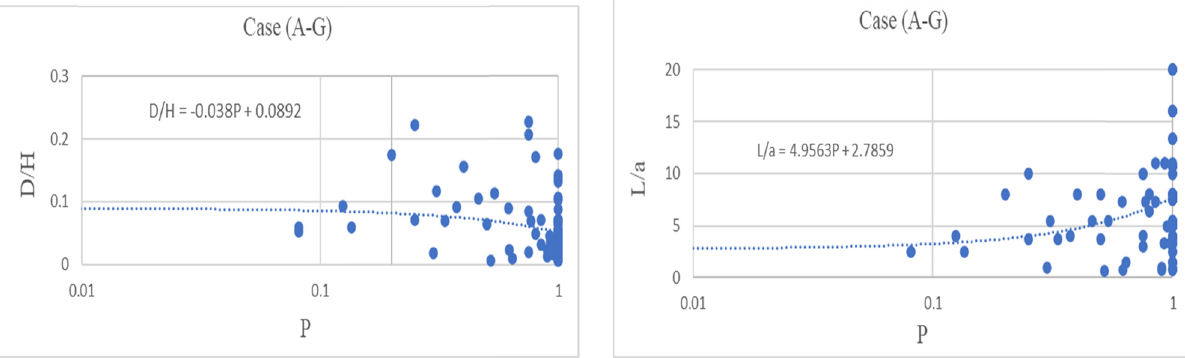
Figure 10: The relation of trunk length to sluice gate opening ( L / a ) to a trap index ( p ) for cases ( A – G ) .